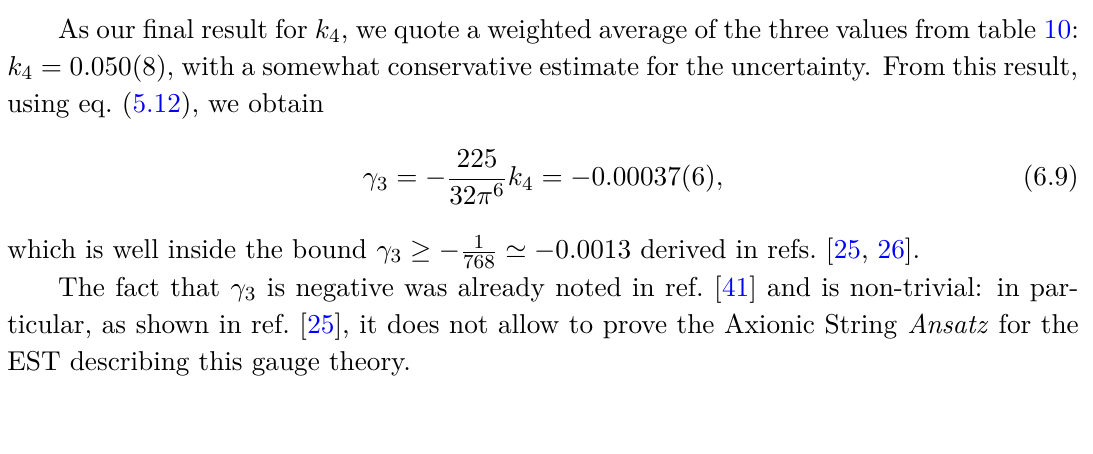
Figure 7 . Fit of our numerical results for the ground-state energy at β = 9 to eq.